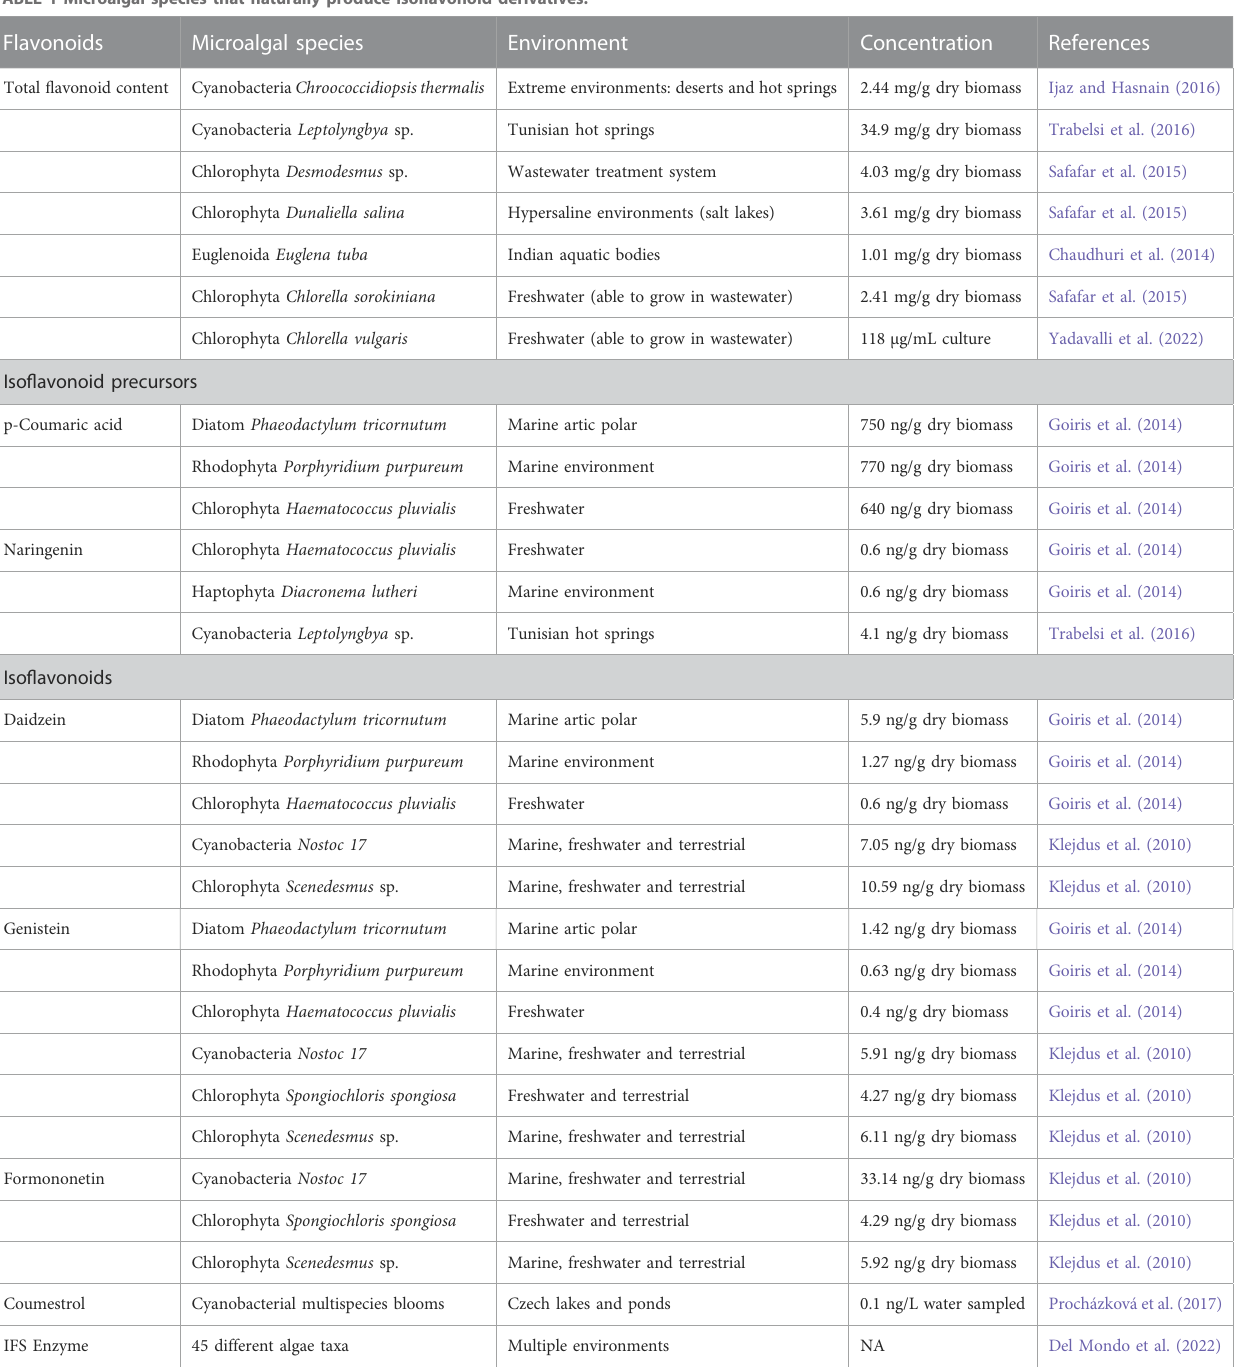
TABLE 1 Microalgal species that naturally produce iso fl avonoid